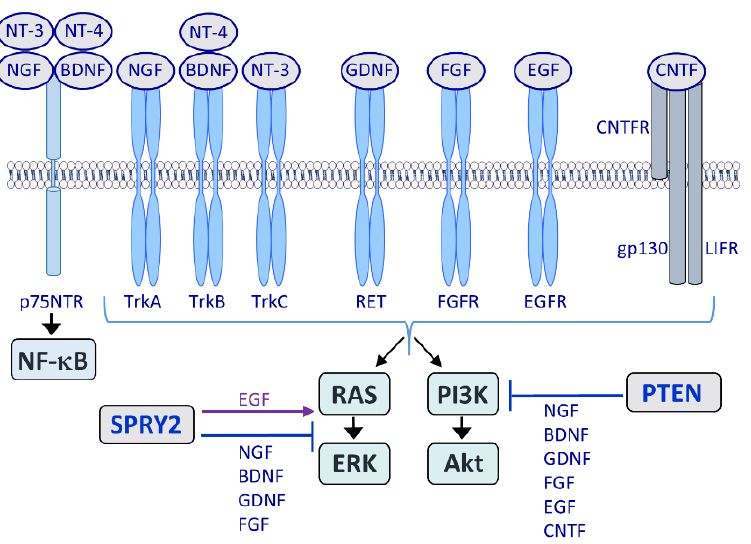
Figure 1. Major growth factor receptors acting in the NS are the tropomyosin receptor kinases (Trks) TrkA, -B and -C, which are activated by nerve growth factor (NGF), brain-derived neurotrophic factor (BDNF), neurotrophin 3 (NT-3) and NT-4. The p75 neurotrophin receptor (p75NTR) acts as a co-receptor for Trks and induces nuclear factor-kappa B (NF- κ B). Glial cell-line-derived neurotrophic factor (GDNF) activates the ‘rearranged during transfection’ (RET) receptor tyrosine kinase (RTK) and among the 22 fibroblast growth factors (FGFs) and four types of FGF receptors (FGFRs), FGF1 and FGF2 together with FGFR1 play a major role during nervous system (NS) regeneration. By contrast, epidermal growth factor receptor (EGFR) activation by epidermal growth factor (EGF) limits regeneration. The neuropoietic cytokine ciliary neurotrophic factor (CNTF) belongs to the gp130 receptor family and the CNTF receptor (CNTFR) is composed of three chains: A specific CNTFR chain, gp130 and leukemia inhibitory factor receptor (LIFR). LIFR does not have intrinsic tyrosine kinase activity but the gp130 and LIFR β chains are constitutively associated with members of the Janus kinase (JAK) family of tyrosine kinases. The rat sarcoma (RAS)/extracellular signal-regulated kinase (ERK) and the phosphoinositide 3-kinase (PI3K)/Akt pathways are activated by all major growth factor and cytokine families. Sprouty2 (SPRY2) inhibits RAS/ERK signaling in response to NGF, BDNF, GDNF and FGF whereas EGF signaling is enhanced by SPRY proteins. Phosphatase and tensin homolog deleted on chromosome 10 (PTEN) inhibits PI3K/Akt signaling in response to NGF, BDNF, GDNF, FGF, EGF and